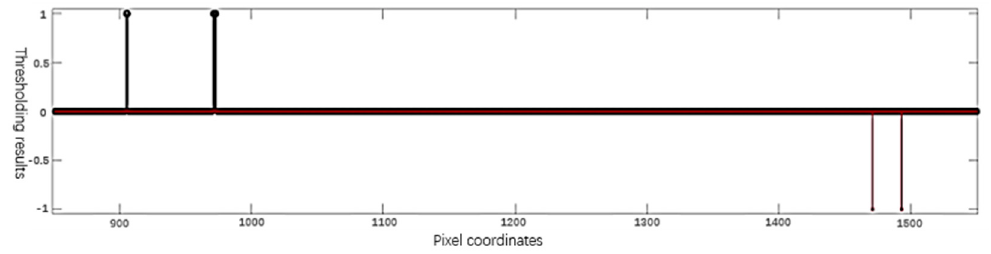
Figure 9. Nut positioning result.